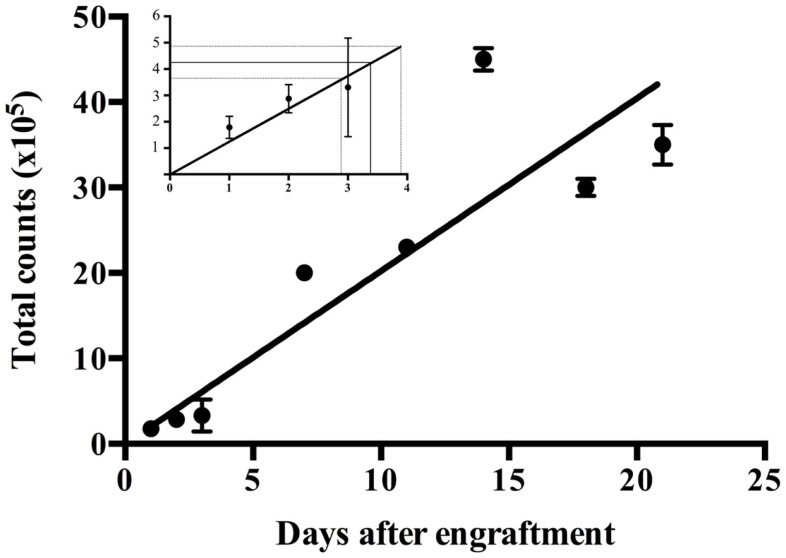
Progression of the bioluminescence signal according to the day after engraftment. Bioluminescence signals were measured for 11 mice up until 21 days after engraftment. The insert focuses on the first 4 days after engraftment. The day after engraftment mimicking the postoperative residual tumor volume, i.e., the disease status after cytoreductive surgery, was determined by reporting the postoperative bioluminescence signals on the y-axis to against the corresponding day on the x-axis.